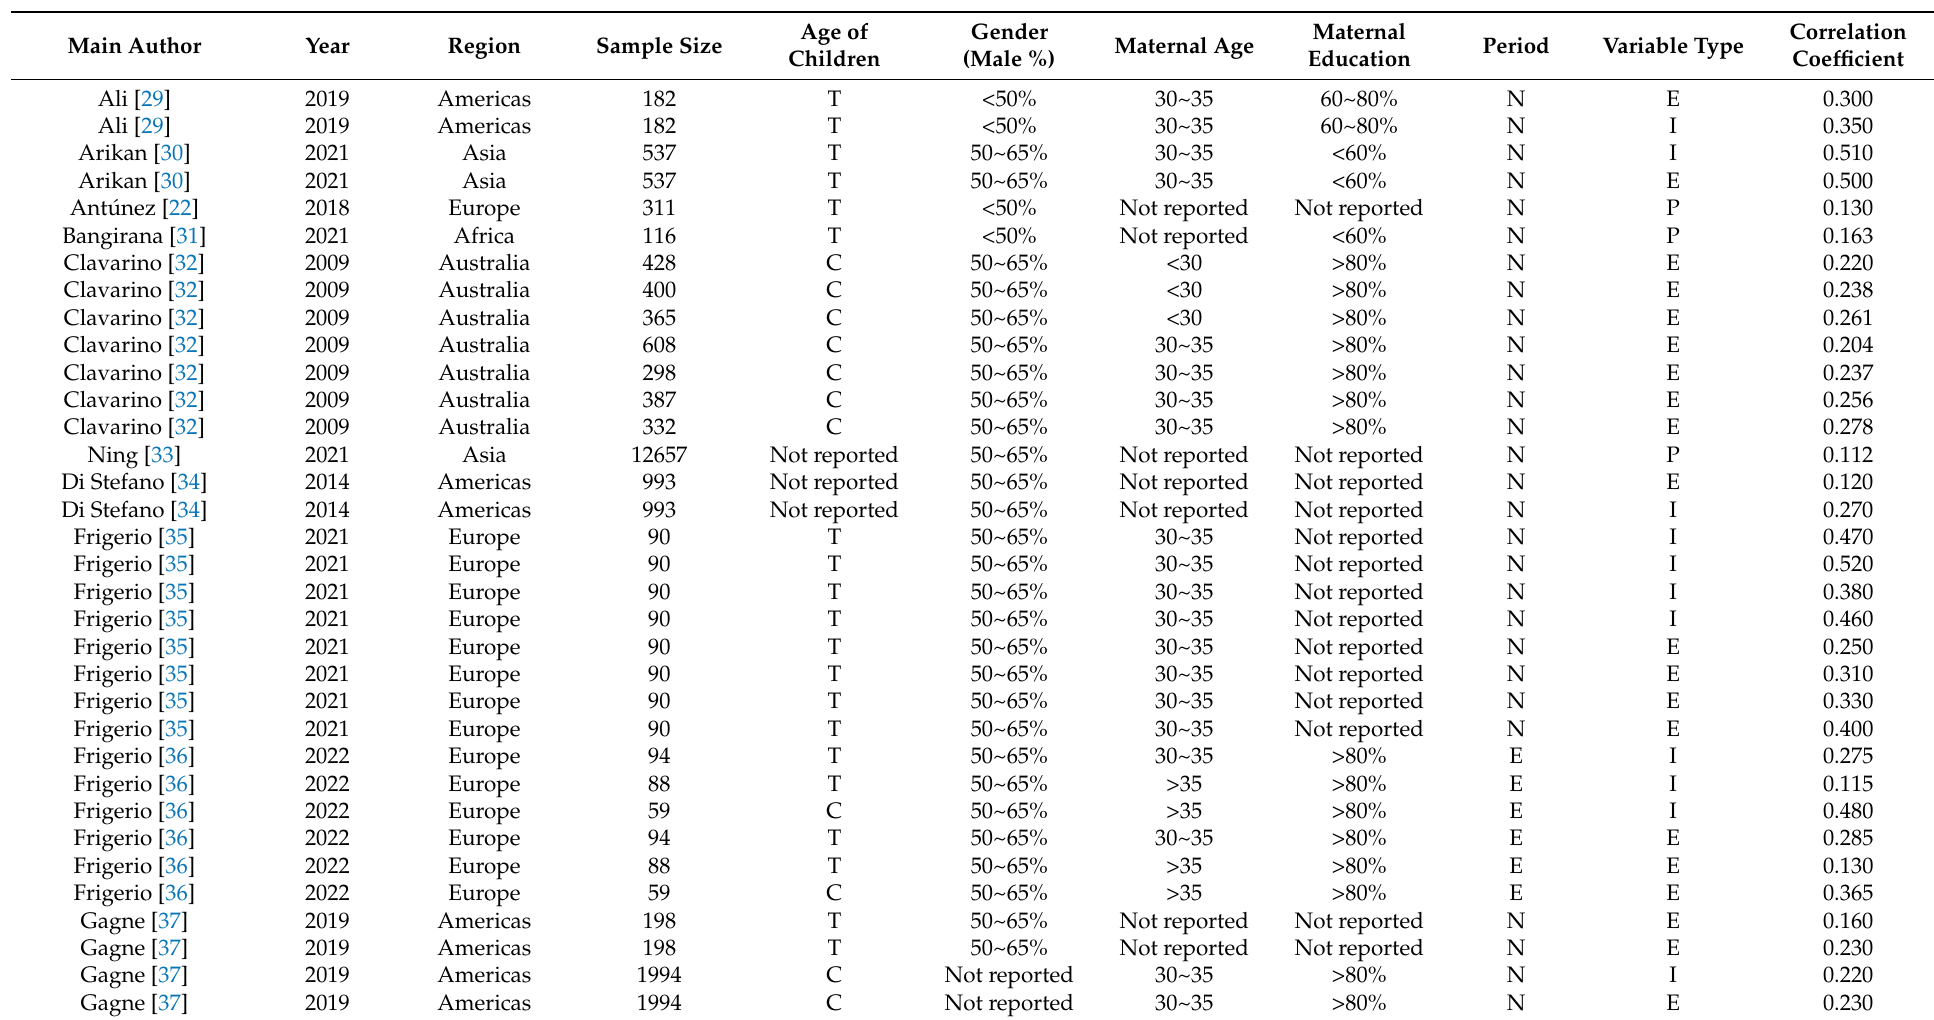
Table 1. Characteristics of the studies included in the